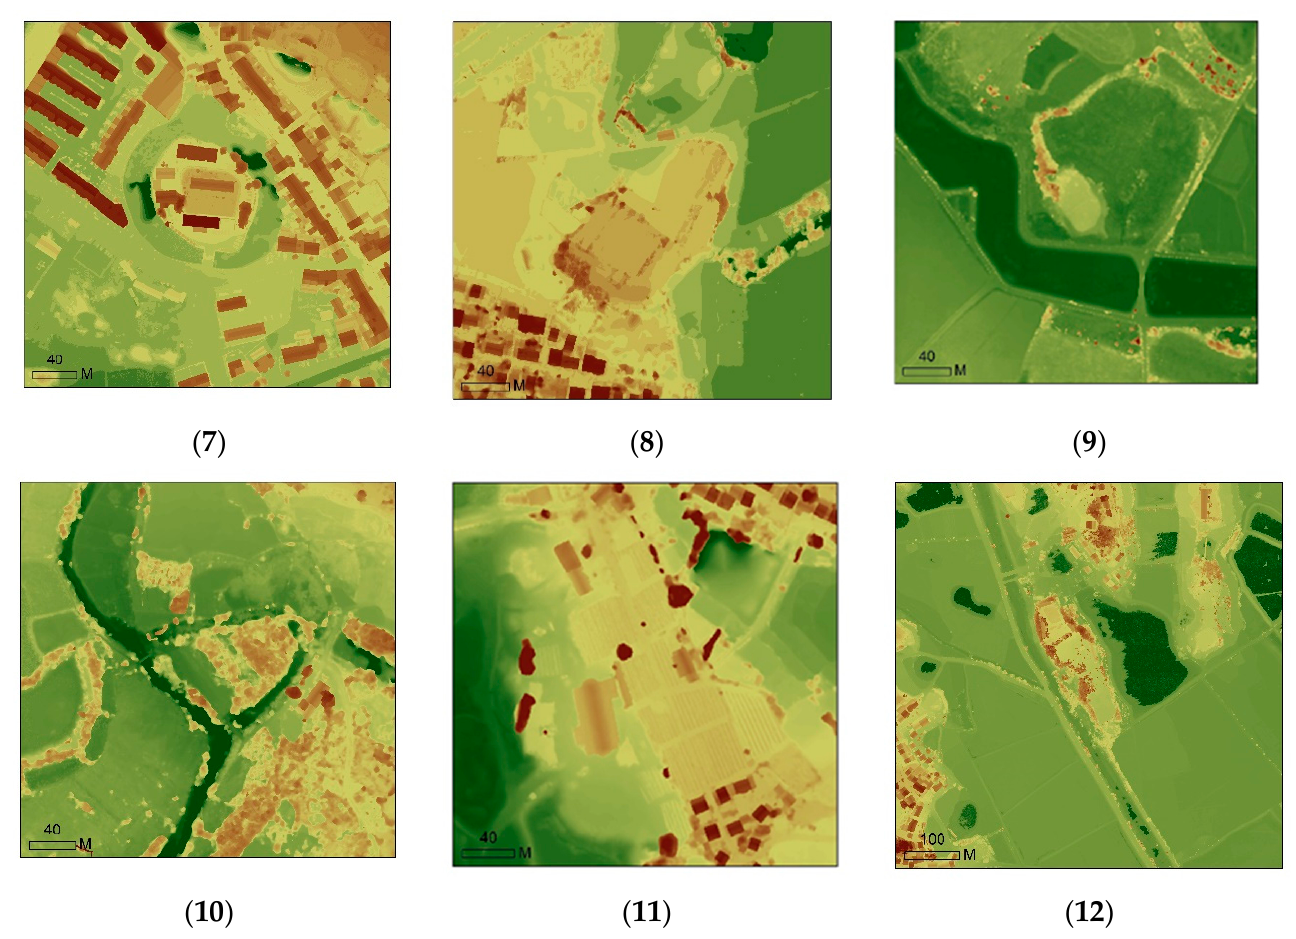
Figure 4. Different types of settlement construction methods, (Type A: ( 10 ) Dadun ( 11 ) Xiayaozui ( 12 ) Zhaishang, Type B: ( 2 ) Zengjiadun ( 3 ) Dunzifan ( 4 ) Fumadun ( 5 ) Leijiazui ( 6 ) Shaishutai ( 7 ) Sigudun ( 8 ) Xiaowangjiashan ( 9 ) Zhaidun, Type C: ( 1 ) Yishengsi).